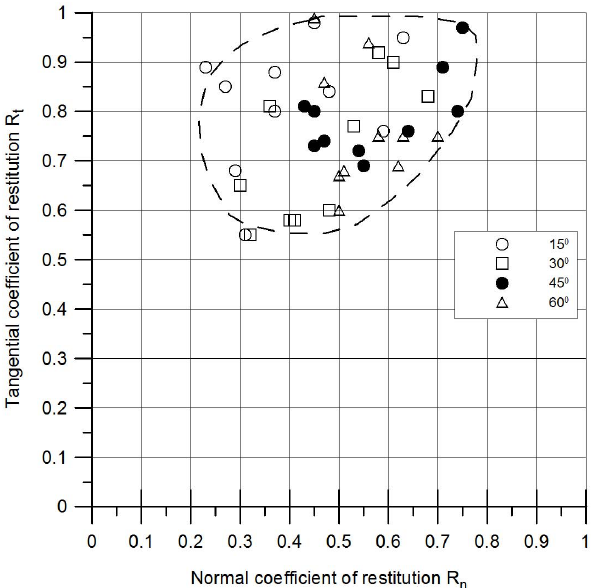
Fig. 7. Range of restitution coefficients, R n and R t for limestone based on laboratory tests (Saroglou et al., 2010).